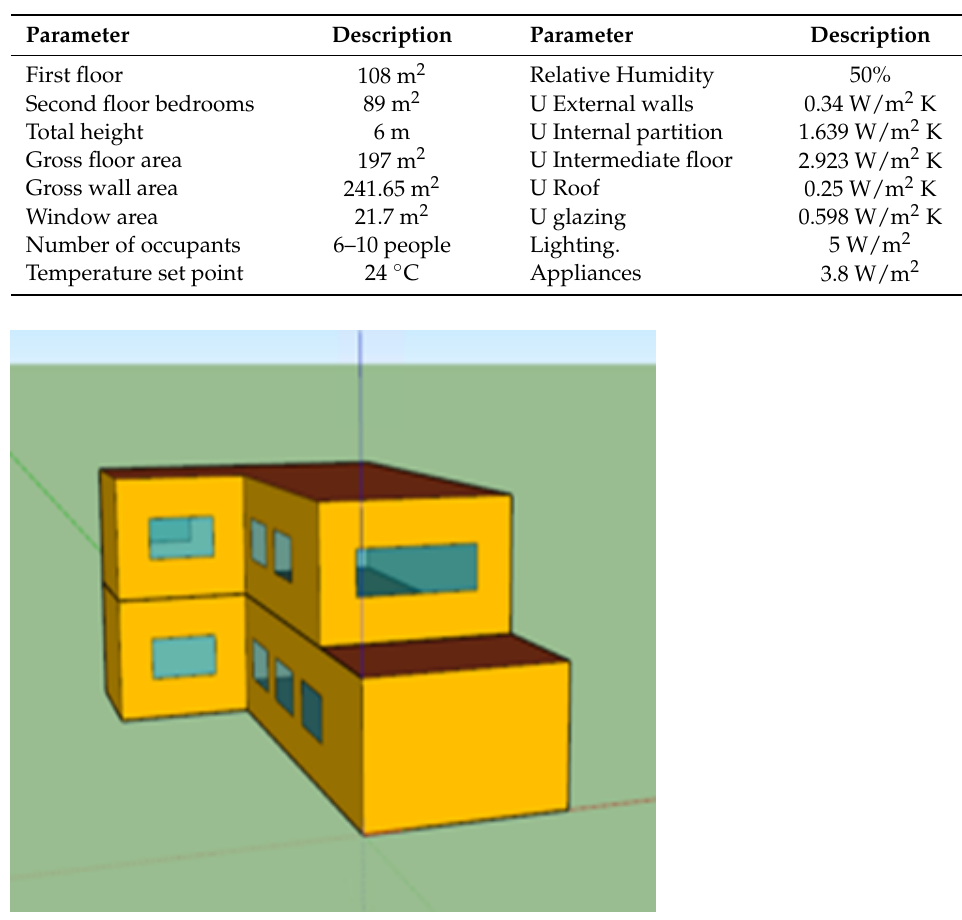
Table 1. Duplex house (villa) construction specifications extracted from [24].